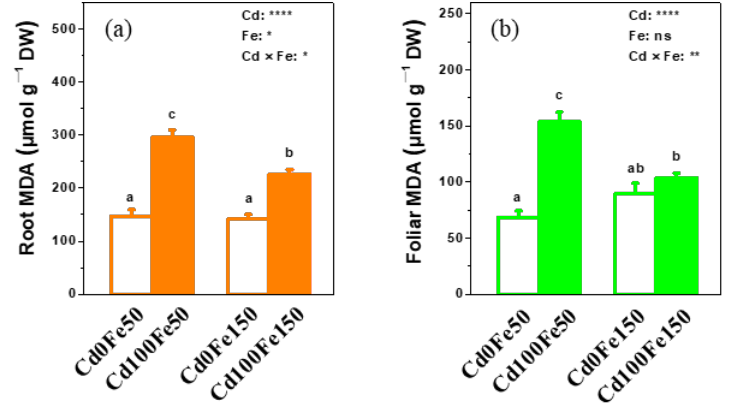
Figure 7. The contents of MDA in the roots ( a ) and leaves ( b ) of poplar under different Cd and Fe combined treatments. Data were means ± SE (n = 6). Different lowercase letters on the bars indicate significant differences in ANOVA ( p < 0.05). p values of two-way ANOVA on Cd, Fe, and their interaction (Cd × Fe) were indicated (*, p < 0.05; **, p < 0.01; ****, p < 0.0001; ns, not significant).